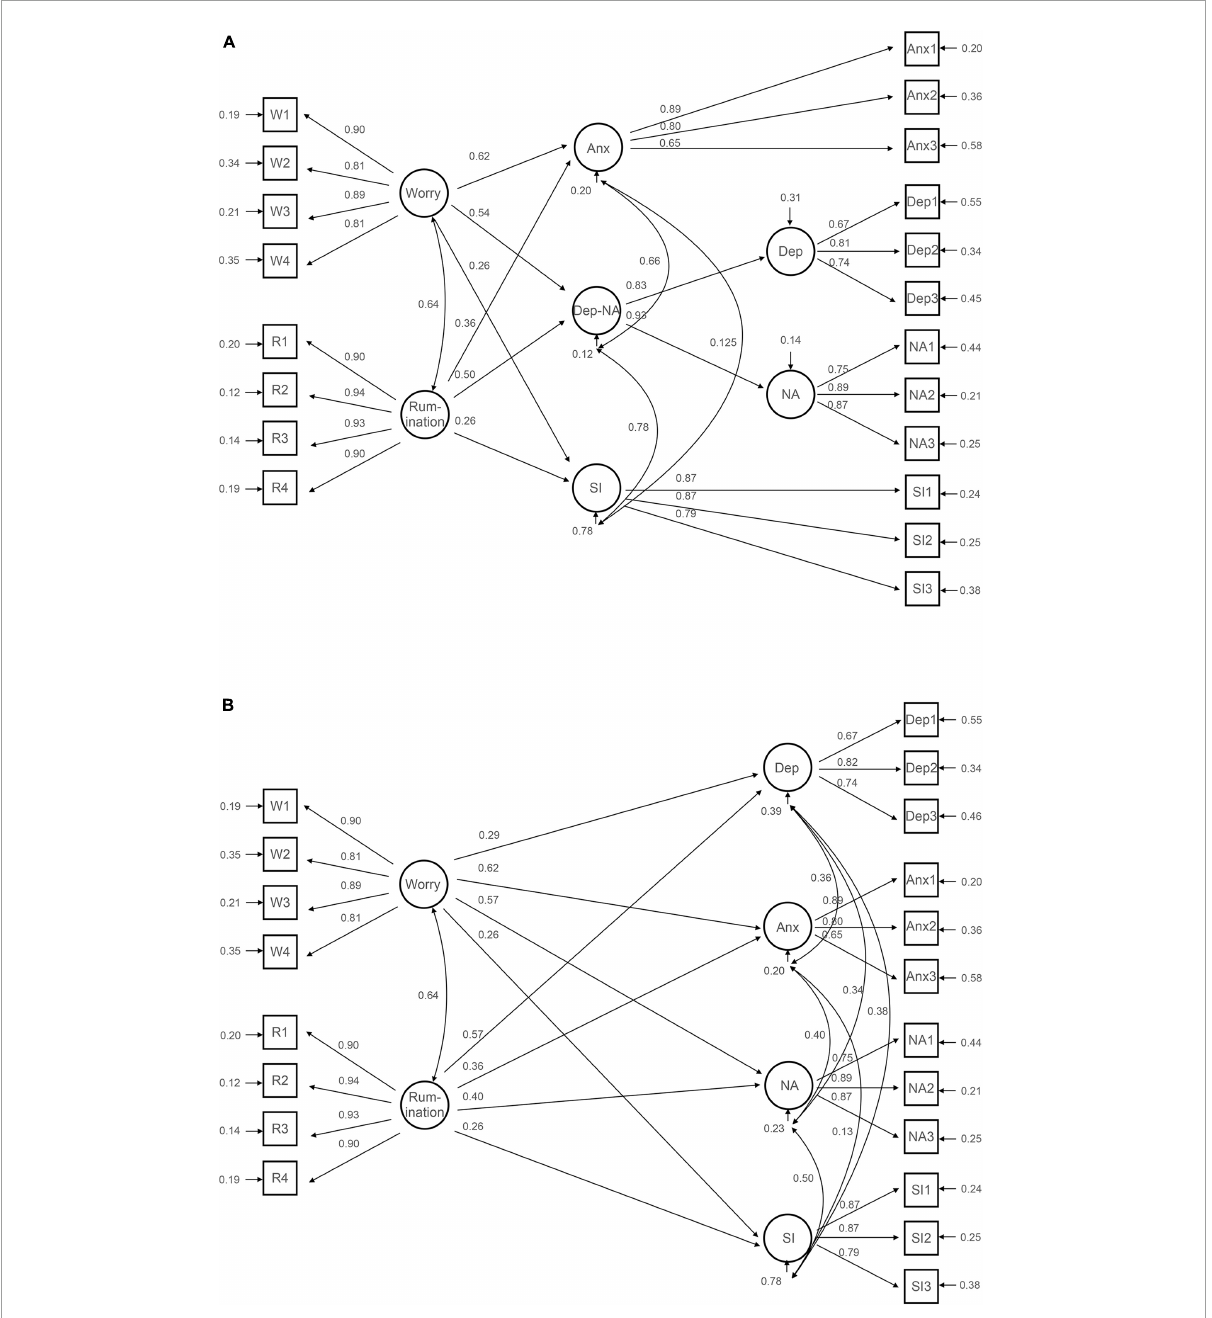
FIGURE3 Structural equation modeling of the relationship between depression, anxiety, type D personality, worry and rumination. The figures shows standardised coefficients. The circles represent latent variables and the squares represent observed variables. (A) Shows the relationship between Worry and Rumination and the factors Anx, Dep-NA and SI. (B) Shows the relationsship between Worry and Rumination and the factors Dep, Anx, NA and SI. Anx, Anxiety; Dep, Depression; NA, Negative Affectivity; SI, Social Inhibition.